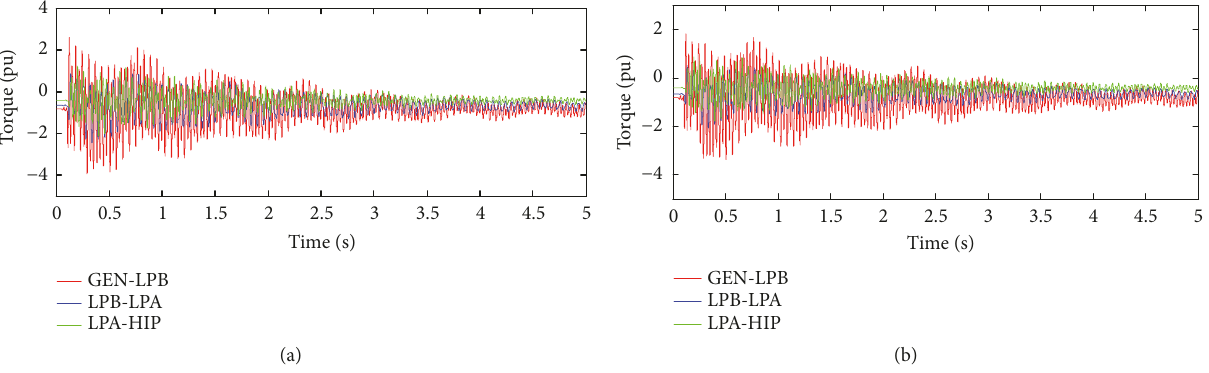
Figure 17: The effect of the SVC on the SSR of Vungang II plant: (a) the torque oscillations in GEN-LPB, LPB-LPA, and LPA-HIP shaft sections of Vungang II plant’s unit 2 under considering Scenario 1; (b) the torque oscillations in GEN-LPB, LPB-LPA, and LPA-HIP shaft sections of Vungang II plant’s unit 2 under considering Scenario